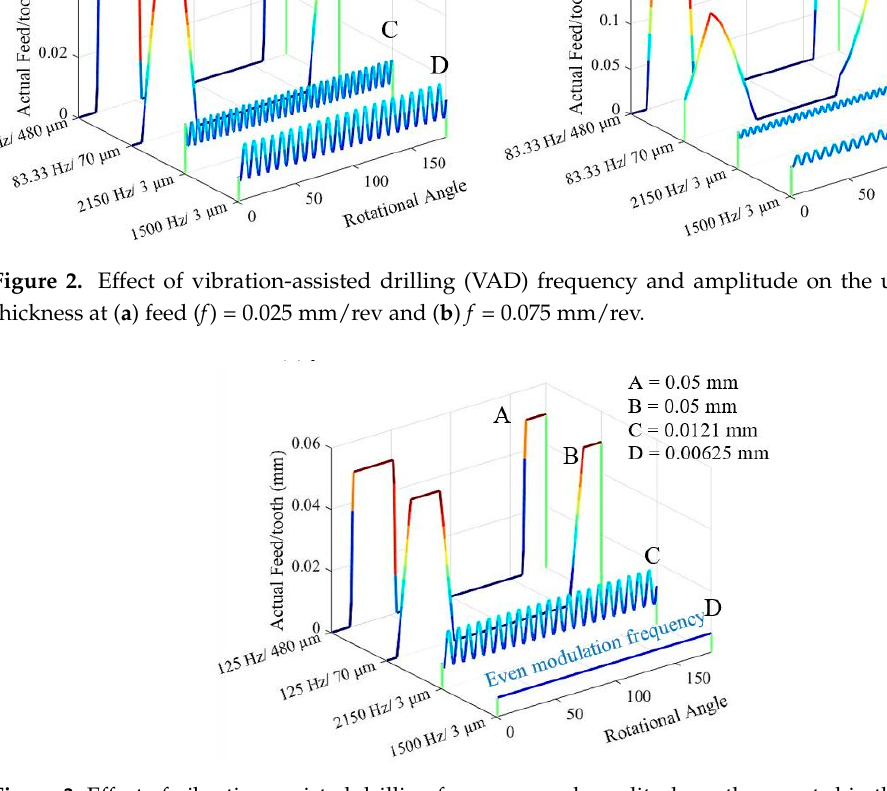
Figure 3. Effect of vibration-assisted drilling frequency and amplitude on the uncut chip thickness at f = 0.025 mm/rev and N = 3000 rpm.